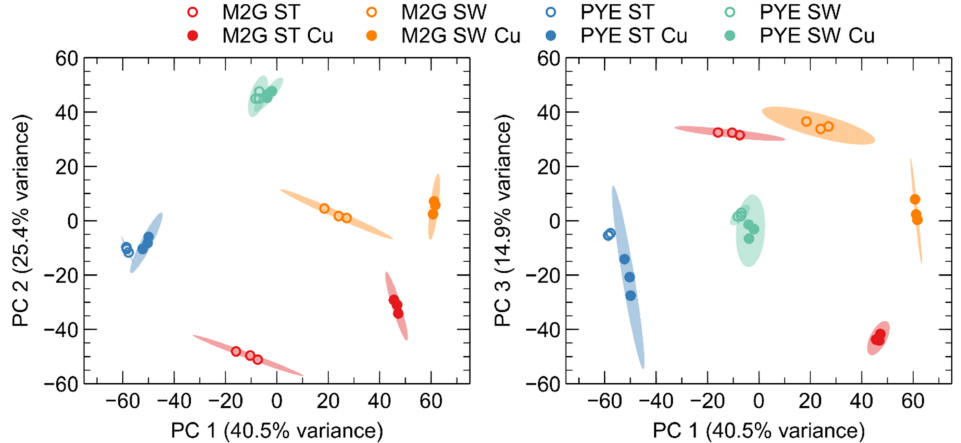
Figure 3. Principal component analysis (PCA) of the log2-transformed normalized gene expression values between the different control (open symbols) and Cu-treated (closed symbols) C. crescentus samples in M2G and PYE medium. PCA plots show the variance of the three biological replicates with 95% confidence level (colored ellipses). The percentages on each axis represent the percentages of variation explained by the principal